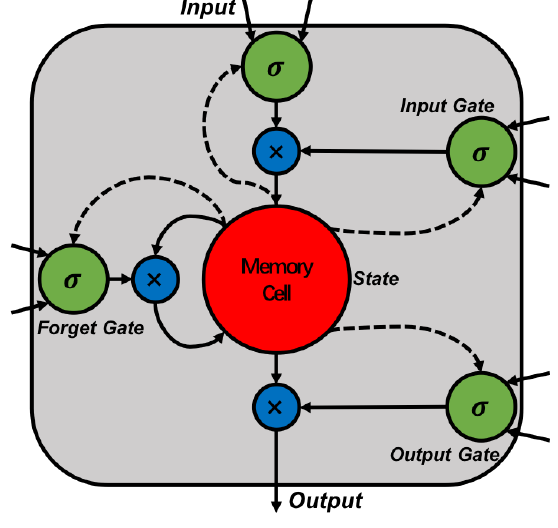
Figure 2. Structure of the long short-term memory (LSTM)